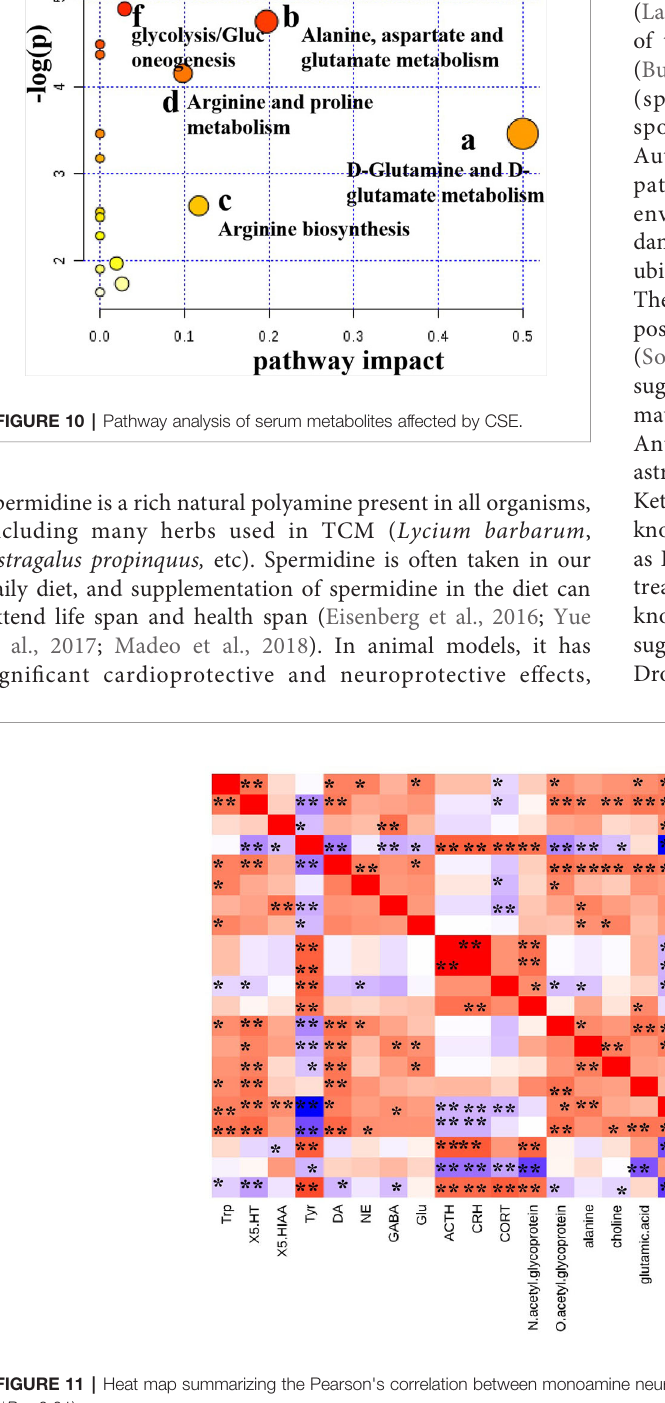
FIGURE 11 | Heat map summarizing the Pearson's correlation between monoamine neurotransmitter, HPA axis hormones, and differential metabolites. (* P < 0.05, ** P <